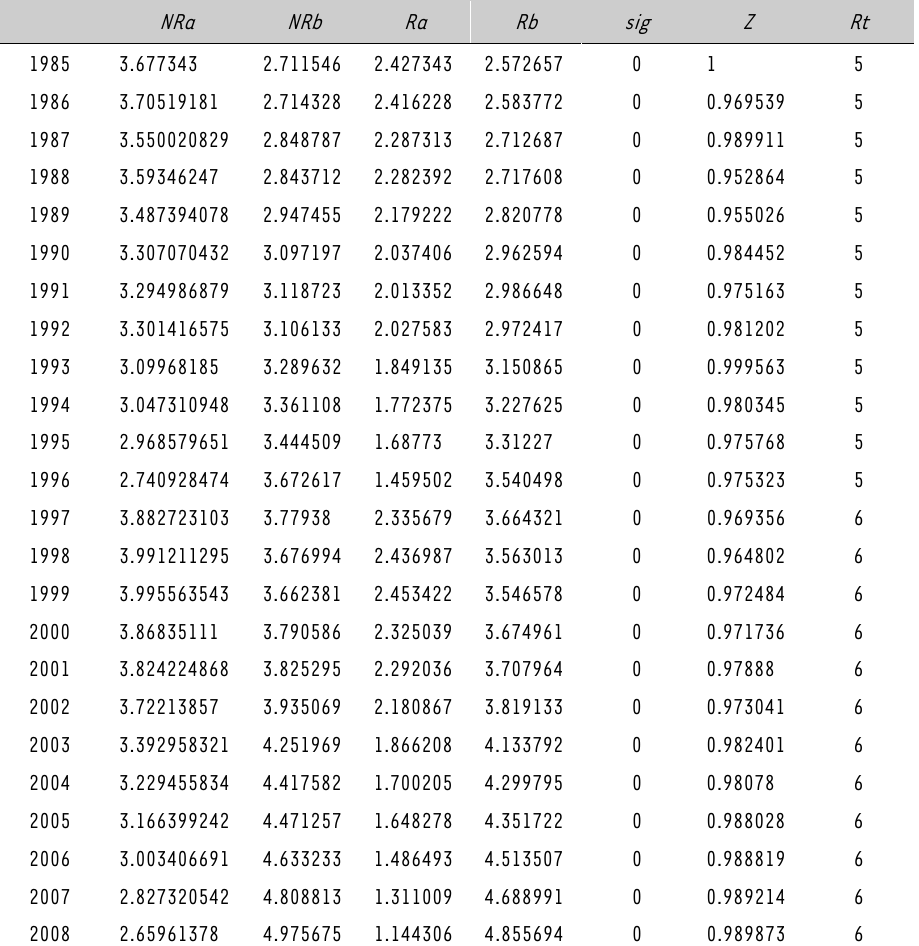
TABLE 6: Data used for South Africa to simulate the reaction function between the ‘environmentalist’ and the ‘energy producer’, when an alternative energy is introduced in